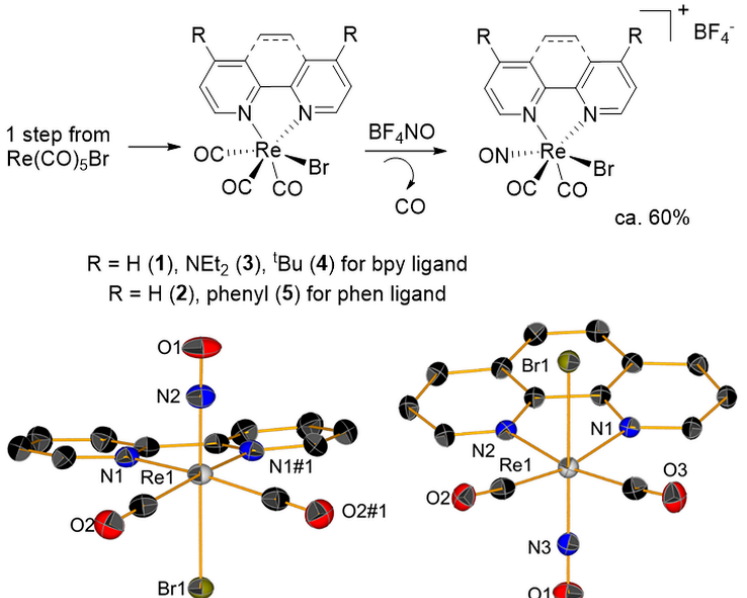
Figure 1. General synthetic approach to fac -[Re(CO) 2 (NO)(N-N)Br] + complexes 1 – 5 (top) and crystal structures of compounds 1 (left) and 2 . Thermal ellipsoids are at 30% probability. Hydrogen atoms and BF 4 − counter ion omitted for clarity. Selected bond lengths (Å): 1 , Re-N1 2.140(4), Re-N2 1.782(6), Re-Br 2.5372(7), Re-CO 1.990(5), C-O 1.123(6), N-O 1.164(7); 2 , Re-N1 2.154(3), Re-N2 2.153(3), Re- N3 1.801(4), Re-Br 2.5425(5), Re-CO 2.002(4) and 2.009(4), C-O 1.118(5) and 1.120(5), N-O 1.143(5). Selected bond angles (°): 1 , O1-N2-Re1 175.3(6); 2 , O1-N3-Re1 178.4(3). Table 1. Physical properties of fac -[Re I (CO) 2 (NO)(N-N)X] + complexes.